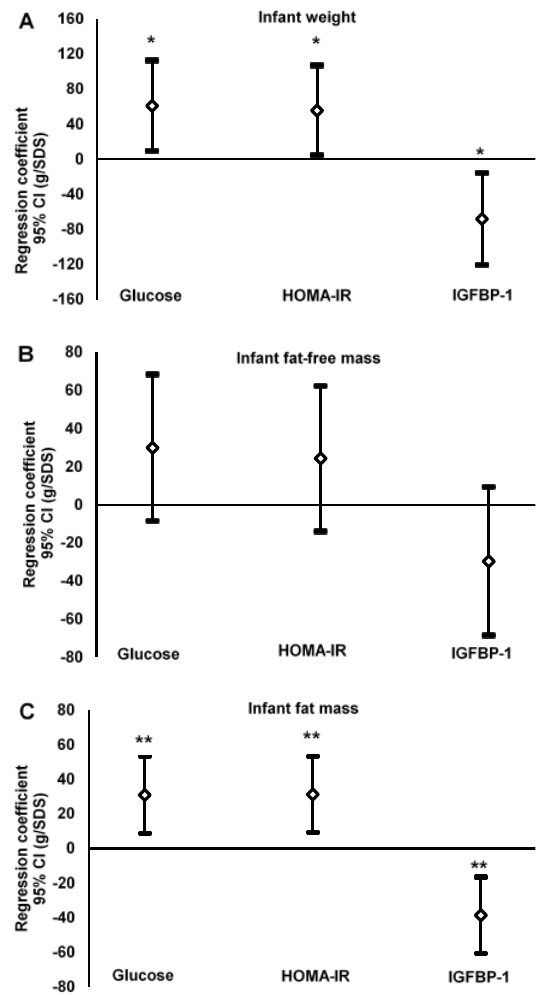
Figure 1. Weight (g), fat-free mass (g) and fat mass (g) of infants at one week of age (dependent variables) regressed on glucose homeostasis variables (glucose, HOMA-IR and IGFBP-1), assessed in the circulation of their mothers when pregnant in gestational week 32 (independent variables). Glucose homeostasis variables are expressed as standard deviation scores (SDS) and estimates are presented as regression coefficients ( b ) in g/SDS with a 95% confidence interval (CI). Regression models were adjusted for maternal parity, infant gestational age at birth, infant sex, and age at measurement. HOMA-IR (homeostasis model assessment-insulin resistance); IGFBP-1 (insulin-like growth factor binding protein-1). Differences between regression coefficient and zero: * p < 0.05, ** p < 0.01, *** p < 0.001. (A) Infant weight glucose: b = 61.0, r 2 = 0.03, n = 209, p = 0.022 HOMA-IR: b = 55.6, r 2 = 0.02, n = 209, p = 0.035 IGFBP-1: b = ´ 68.2, r 2 = 0.03, n = 204, p = 0.011 (B) Infant fat-free mass glucose: n = 209, p = 0.13 HOMA-IR: n = 209, p =